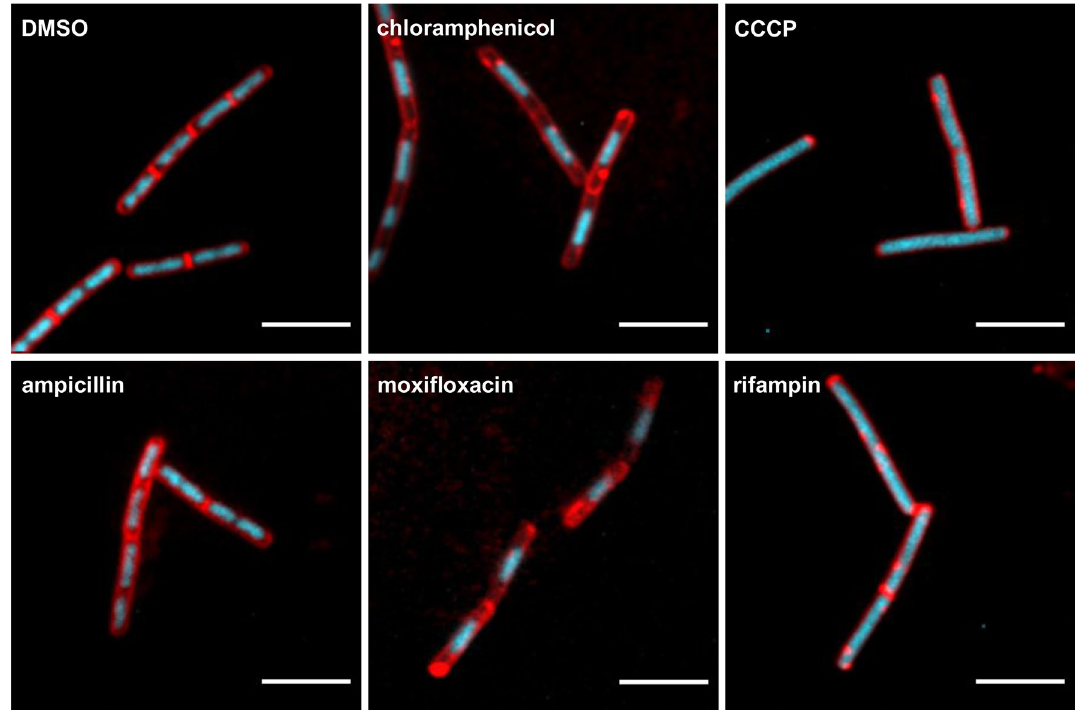
Figure 1. Cytological profiling of antimicrobial activities. B. subtilis cells were treated with an antimicrobial from one of the five main MoA classes or 1% DMSO (control) for 60 min. The antimicrobials we selected were: ampicillin for cell wall, CCCP for cell membrane, chloramphenicol for protein, moxifloxacin for DNA and rifampin for RNA. The concentrations of antimicrobials were 2.5 × MIC. Cells were stained with FM4-64 (red, cell membrane) and DAPI (blue, nucleoid), immobilized and imaged by confocal fluorescence microscopy. Representative images are shown. Scale bar is 5 µm.